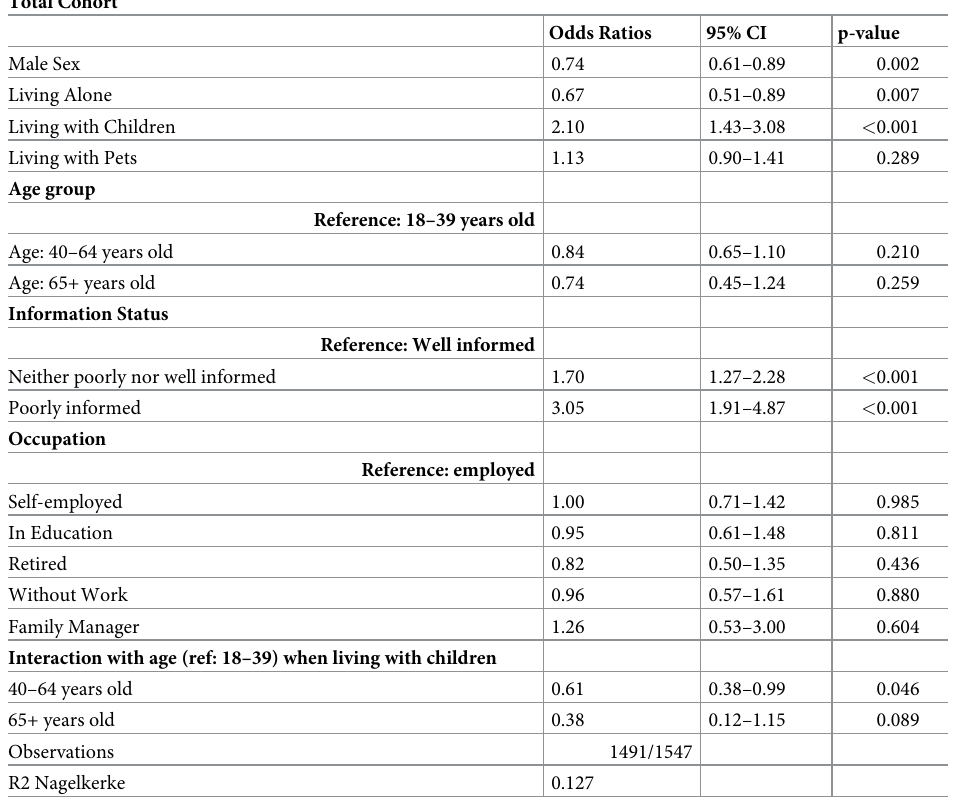
Table 2 describes association of sociodemographic background with the perceived difficulty level of adherence to isolation recommendations overall in all 1493 participants who stated their overall difficulty